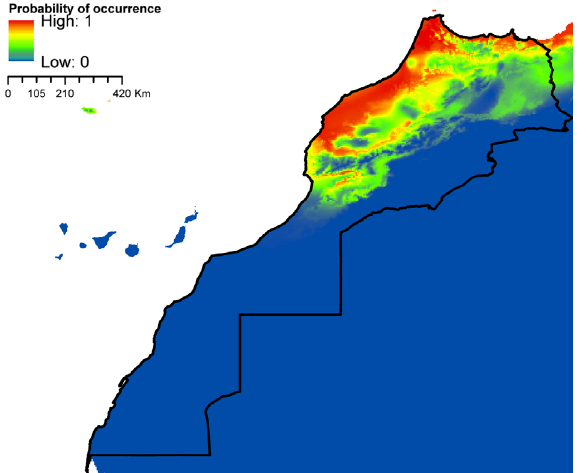
Figure 5. Predicted distribution of Cx. pipiens in Morocco.